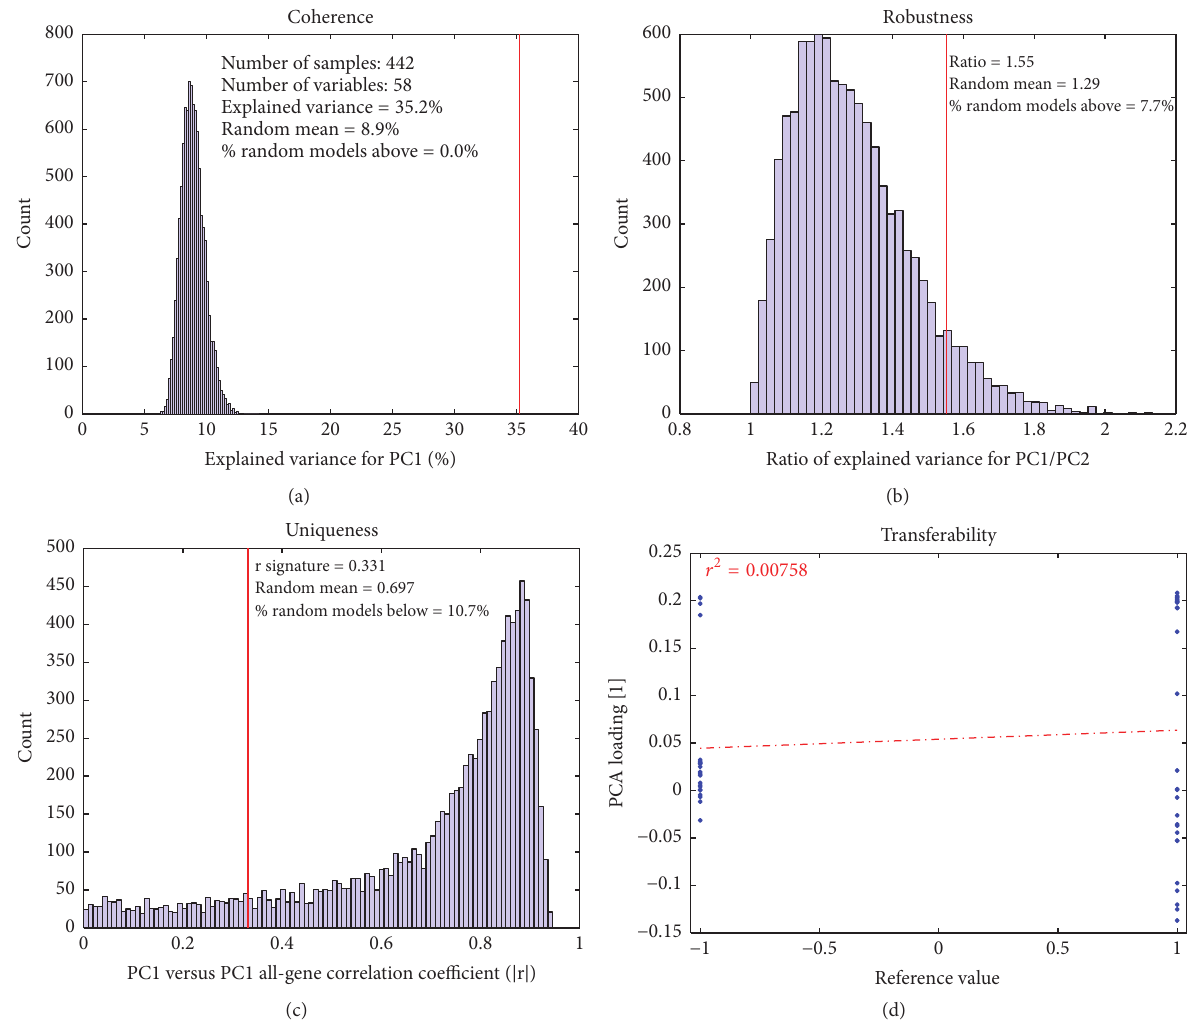
Figure 5: Validation plot for Mix-29/29 signature applied to DC dataset. Merging two “good” signatures and applying the resulting signature to a relevant dataset do not mean that the new signature will be valid. The probesets in the Mix-29/29 signature have a coherent expression (a), but the ratio of PC1/PC2 (b) is lower than that in the individual signatures. The uniqueness is also slightly worse (c). That the Mix-29/29 model is not working as expected is clearly seen in the transferability plot (d), where the PCA model for the DC dataset is not related to reference